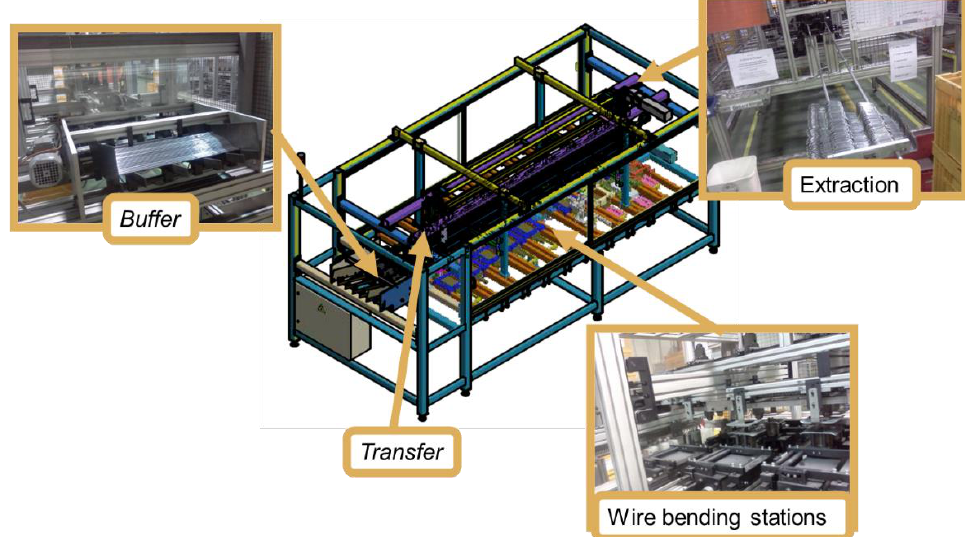
Figure 6. Specific wire-bending machine with transfer.